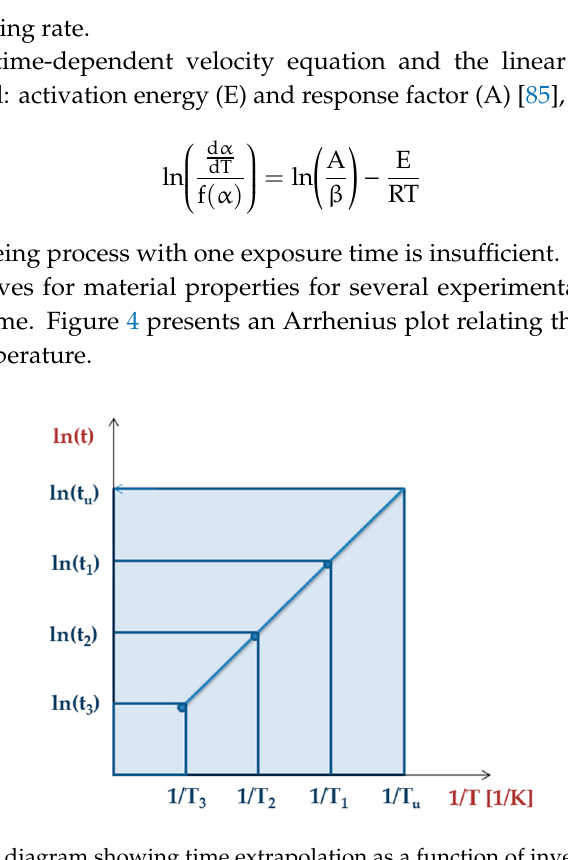
Figure 4. Arrhenius diagram showing time extrapolation as a function of inverse temperature [59].